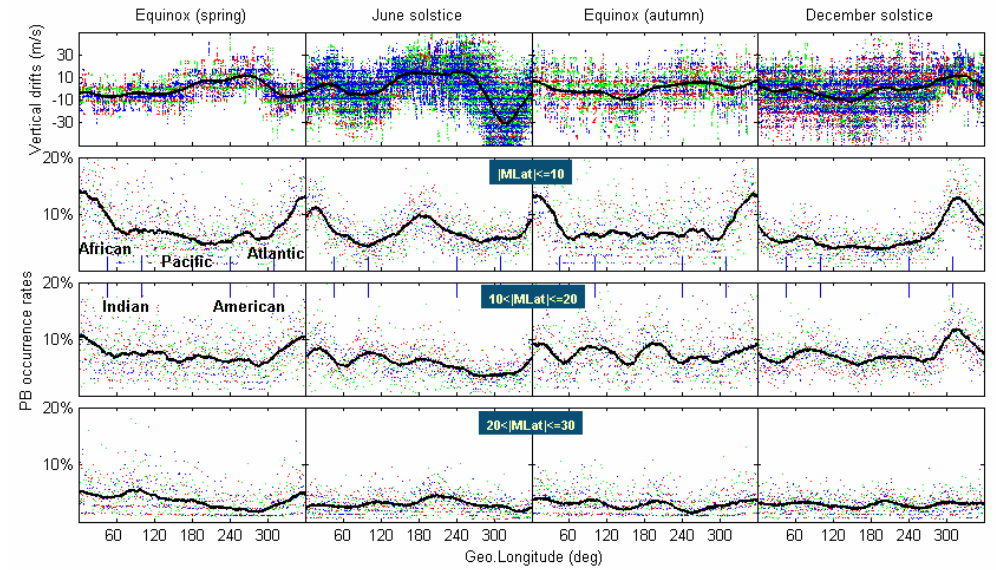
Figure 4. Plot of the relative variations of evening equatorial vertical drift (obtained from DMSP F13, near 18:00 LT) (top panels), and plasma bubble occurrence probability (obtained from DMSP F15, near 21:30 LT) (middle and bottom panels) versus longitude for equinoctial and solstitial seasons.